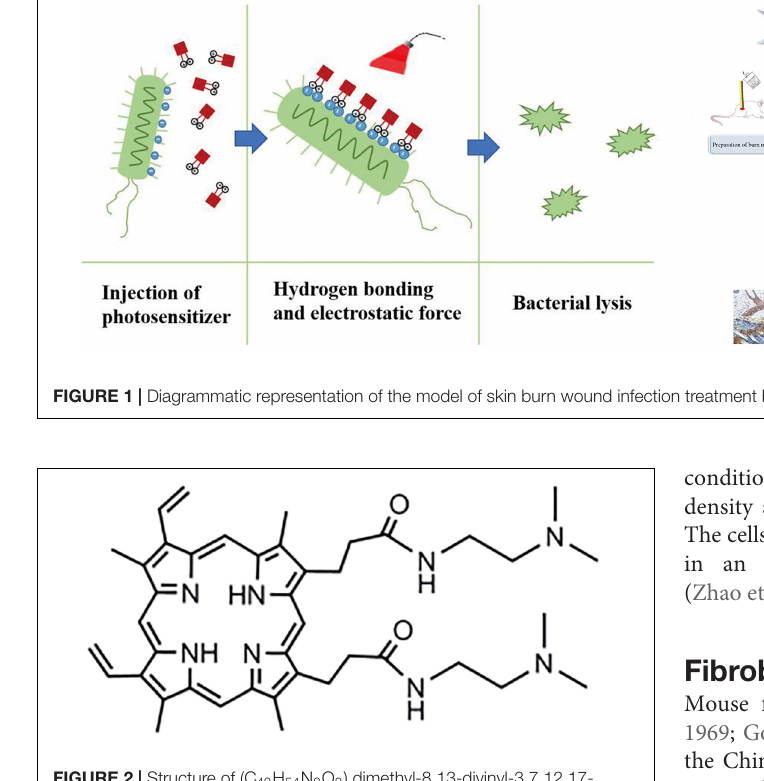
FIGURE 2 | Structure of (C 42 H 54 N 8 O 2 ) dimethyl-8,13-divinyl-3,7,12,17- tetramethyl-21H, 23H-porphyrin-2,18- bis [- N -2-(dimethylamine)ethyl] propenamide